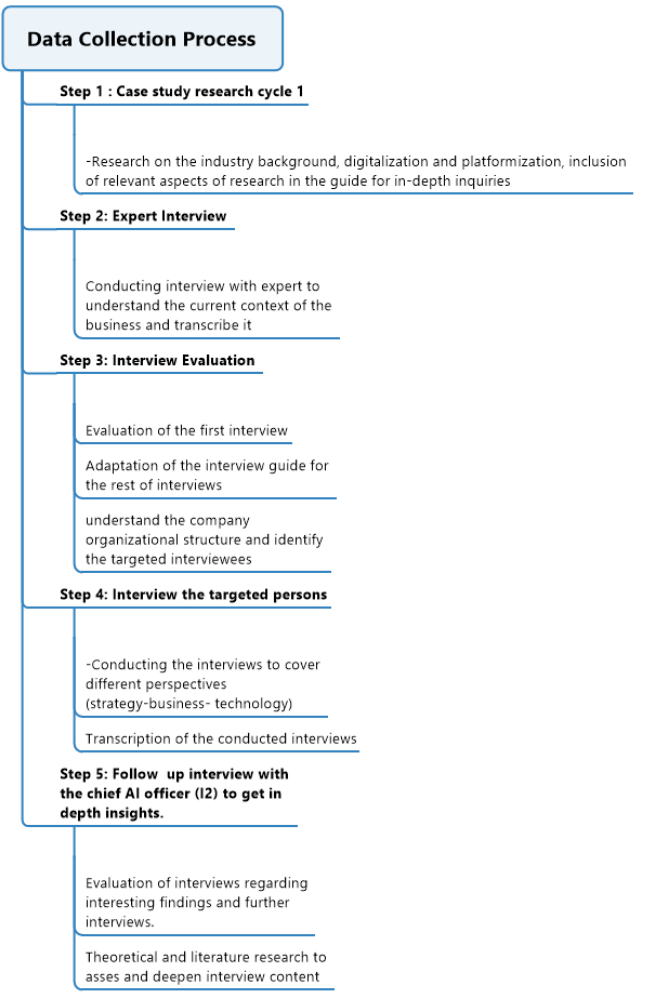
Figure 3. Data Collection